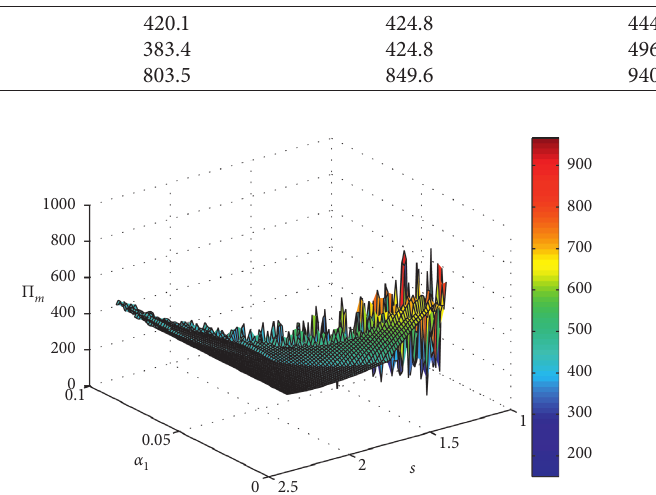
Figure 17: 3D profit diagram for the manufacturer with α